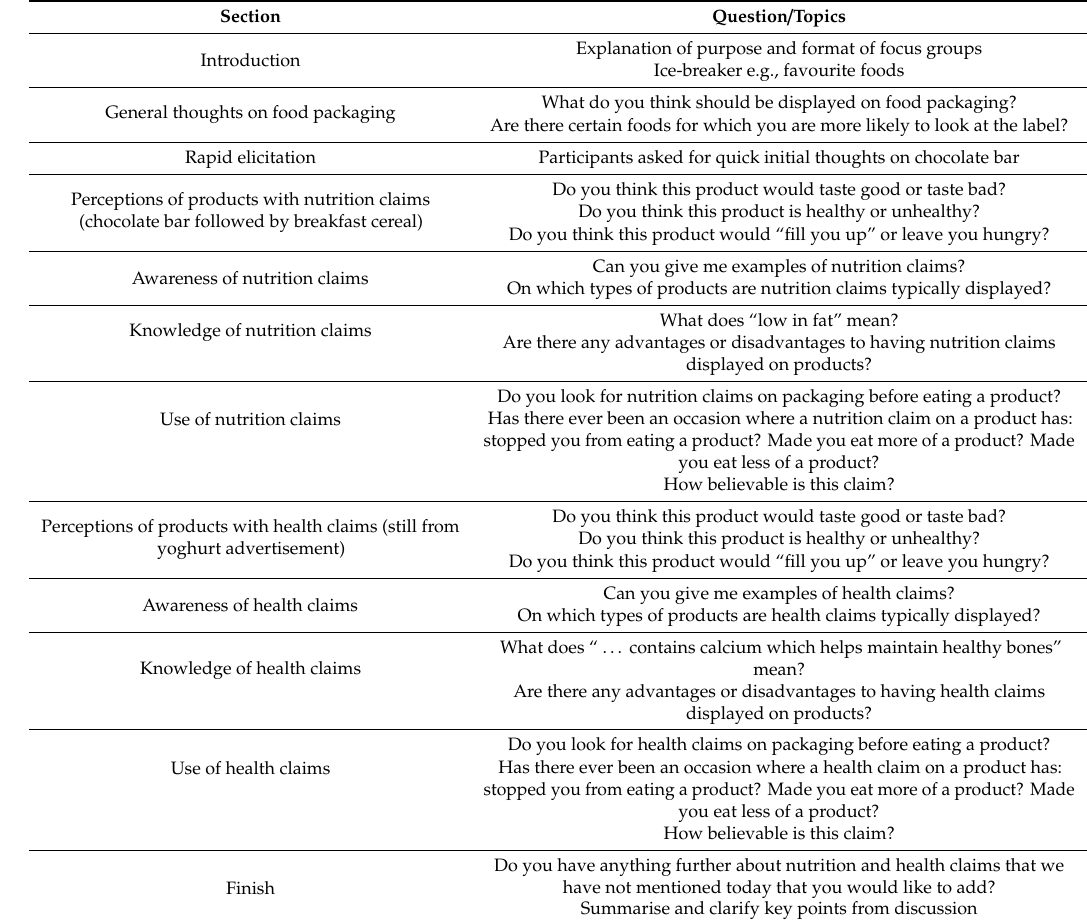
Table 3. Overview of topic guide used in focus